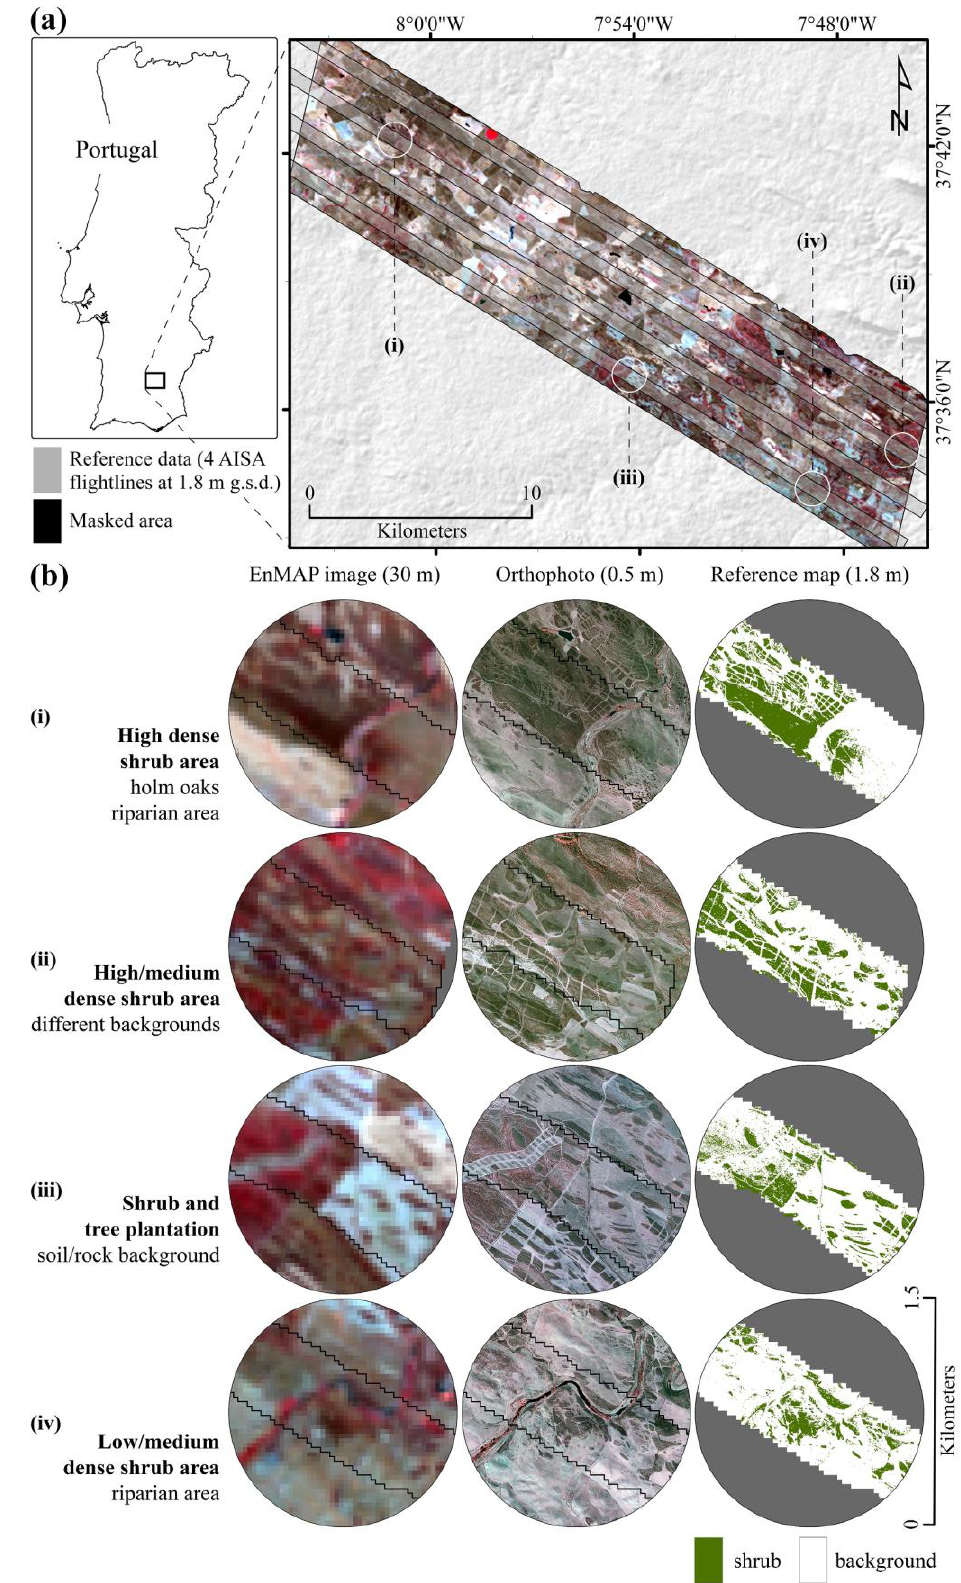
Figure 1. ( a ) Simulated EnMAP scene (red = 863 nm, green = 652 nm, blue = 548 nm) covering the study area. Areas with available reference data appear semi-transparent. ( b ) Four selected spatial subsets are highlighted with aerial photographs ( center ) and a reference shrub cover map ( right